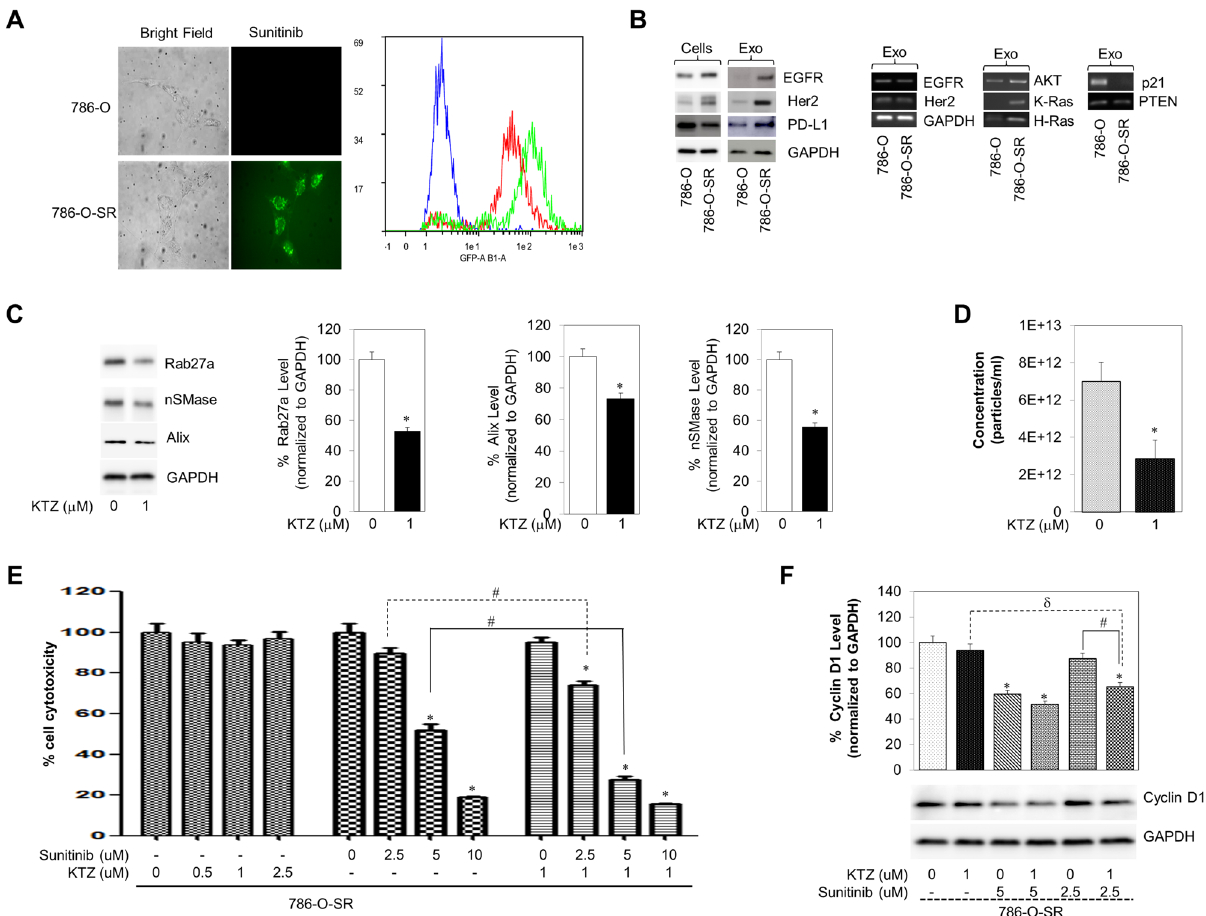
Figure 5. Effect of KTZ co-exposure on 786-O or 786-O-SR cells. (A; left panel) Typical fluorescence microscope image of 786-O-SR cells following treatment with 5 µM sunitinib, exhibiting fluorescent granules (magnification, × 40). ( A ; right panel) Sunitinib autofluorescence in control (Blue) or sunitinib-treated 2.5 μM (Red), and 5 μM (Green) 786-O cells after incubation for 24 h by MACSQuant analysis. This figure was generated using MACSQuantify Software version 2.1.3. This software can be found at https:// www. milte nyibi otec. com/ US- en/ produ cts/ macsq uanti fy- softw are. html# 130- 094- 556. ( B -Left panel) Total cells and exosome protein lysates were prepared from 786-O and 786-O-SR cells. Proteins were subjected to immunoblot analysis with antibodies against EGFR, Her2, PD-L1, and GAPDH. ( B -right panel) Conventional PCR analysis of EGFR, Her2, H-Ras, K-Ras and GAPDHs in the exosome derived from 786-O and 786-O-SR cells. ( C ) KTZ significantly inhibited the protein expression of Alix, nSMase and Rab27a in a dose-dependent manner in 786- O-SR. ( D ) qNano-IZON particle quantitative analysis (NP-100 nanopore) depicting a significant decrease in exosome concentrations (50–200 nm size) in the CM of 786-O-SR cells treated with KTZ compared to vehicle treated control. *Denotes significance at p < 0.05 compared to controls and was calculated using GraphPad Prism. (E) MTT cell proliferation assays showed that KTZ potentiated sunitinib inhibition of 786-O—Sunitinib Resistance (786-O-SR) cells growth. KTZ synergistically enhanced Sunitinib’s cytotoxicity to 786-O-SR cells when the two drugs were combined at the IC50 concentration equivalent for each drug. (F) The 786-O-SR cells were treated with the indicated concentrations of sunitinib, ketoconazole or combination drugs for 48 h. Lysates were analyzed by western blot analysis using the indicated antibodies. Relative expression levels of cyclin D1 protein were compared between control cells and cells treated with the indicated drugs by western blot. GAPDH immunoblot used as loading control. Error bars represent SD. Three independent experiments were performed in triplicate. *Denotes significance at p < 0.05 compared to controls. d Denotes significance at p < 0.05 compared between KTZ-treated group and combination-treated group. Full blots are presented in Supplementary Fig. S6. # Denotes significance at p < 0.05 compared between sunitinib-treated group and combination-treated group and was calculated using GraphPad Prism. Data for EVs and exosomes was captured using IZON’s Control Suite software version 3.4.2.48, https:// suppo rt. izon. com/ how- can-i- get- the- latest- softw are- relea